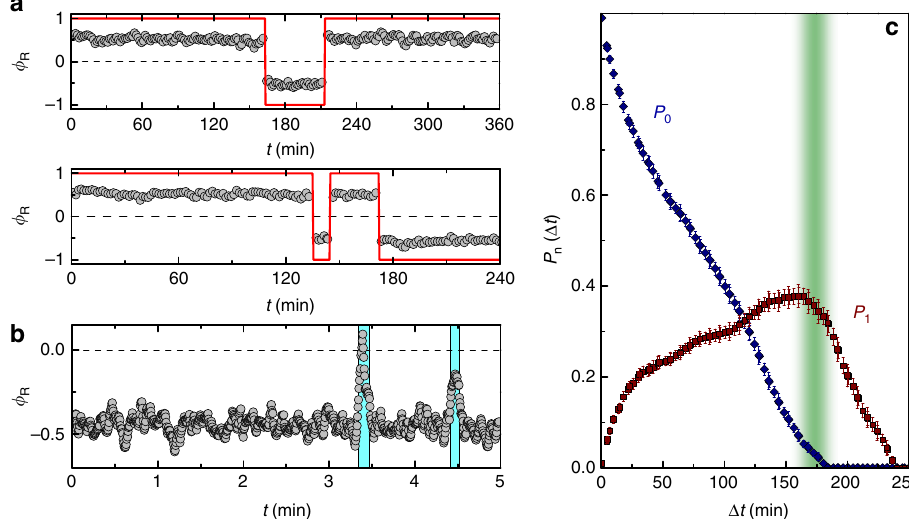
Fig. 2 Chirality switching statistics of a roller vortex. a Chirality switching events illustrated by the polar order parameter of a roller vortex formed in a soft harmonic gravitational con fi nement. B 0 = 5.78 mT, f B = 40 Hz. b Events of the fl ock intermittency not resulted in a roller vortex chirality switch. c Probability distribution functions for the roller vortex to have no chirality switching events ( P 0 ) or have one successful chirality change ( P 1 ). Error bars are the standard deviation of the